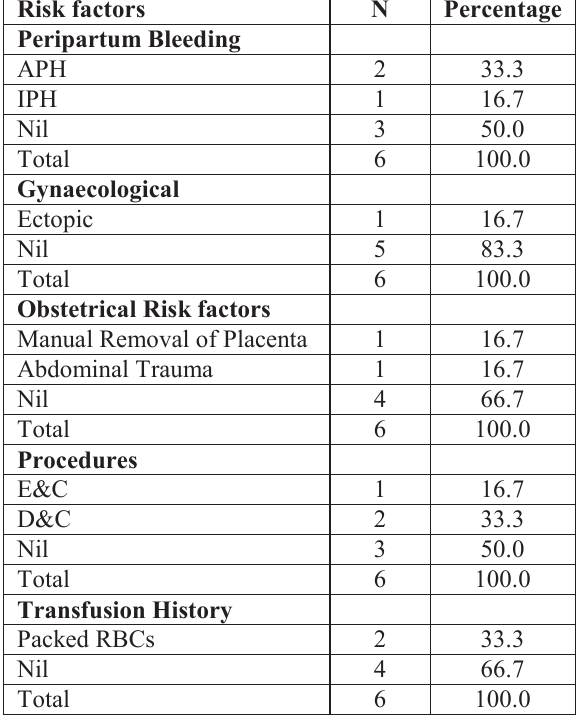
Table-2: Risk Factors in Previous Pregnancies in Alloantibody Positive Cases